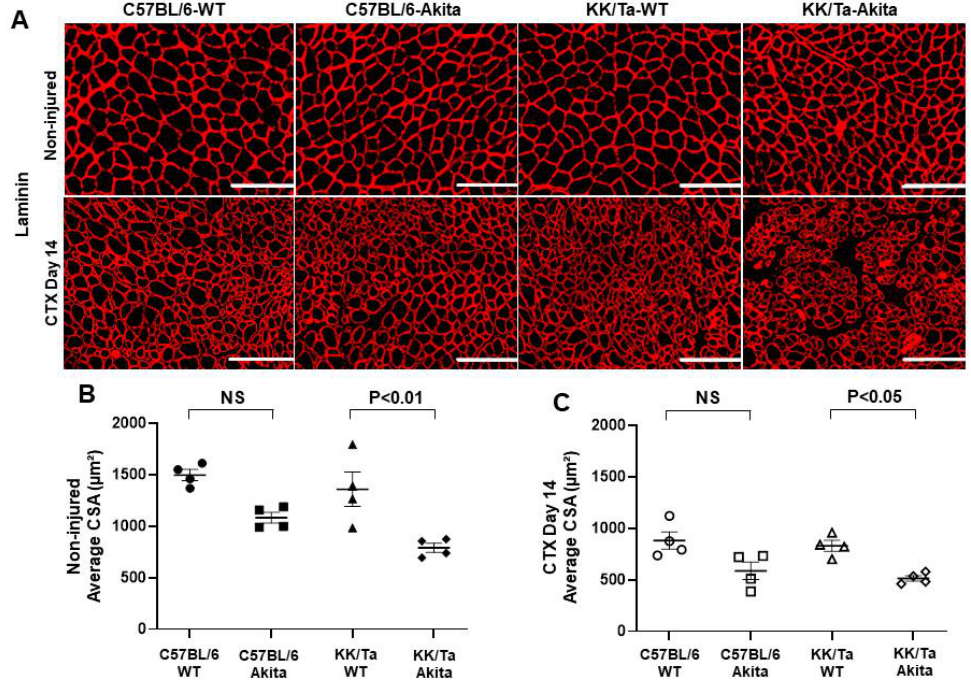
Figure 3. Assessment of regeneration in TA muscles on day 14 after saline (non-injured) or CTX injection. ( A ) Representative images of laminin immunofluorescent staining in TA muscles. Bars = 200 µ m. ( B ) Average cross-sectional area (CSA) of regenerating TA muscle myofibers on day 14 after saline injection. ( C ) Average CSA of regenerating TA muscle myofibers on day 14 after CTX injection. Data are presented as means ± SEM. n = 4 per group.